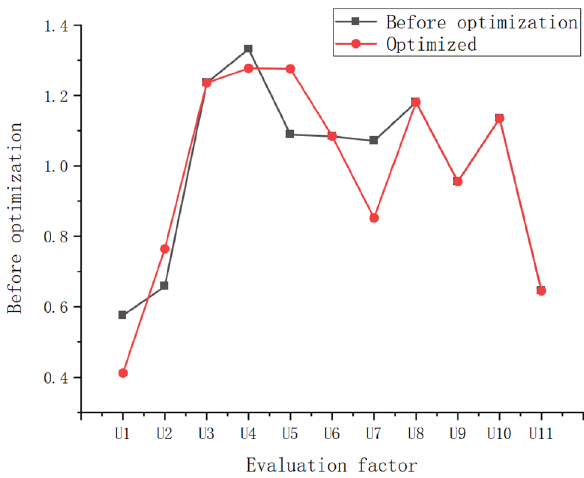
Figure 6. Comparison of spatial distance κ before and after optimization.